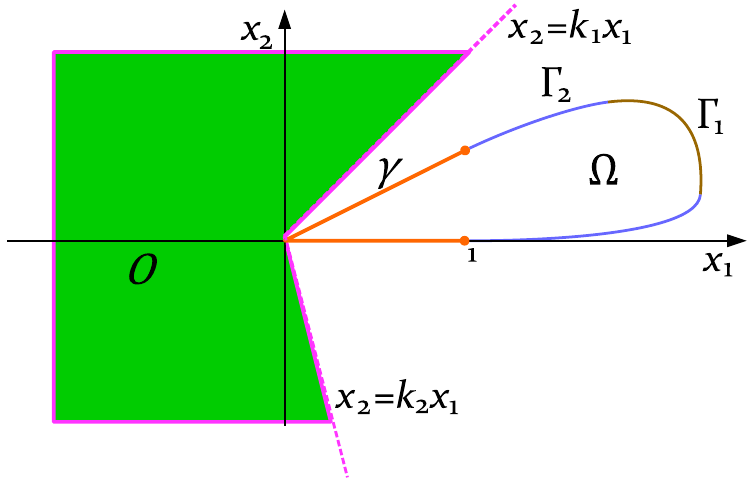
Figure 3. Geometry of the composite body and the rigid obstacle with an obtuse